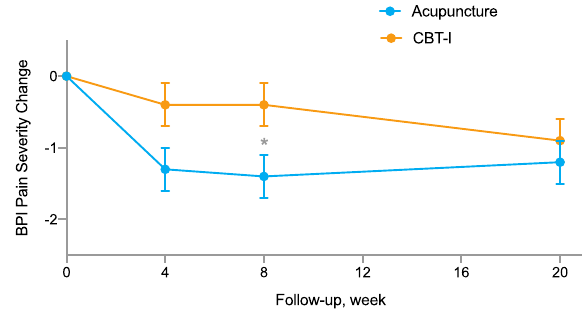
Fig. 2 Effect of acupuncture and CBT-I on pain severity. Figure 2 illustrates the trajectory of Brief Pain Inventory severity score changes from baseline to week 20 in the acupuncture versus CBT-I group. The asterisk mark (*) indicates a within-group difference with statistical signi fi cance ( p < 0.05). Error bar indicates standard error of the mean. CBT-I cognitive behavioral therapy for insomnia, BPI Brief Pain